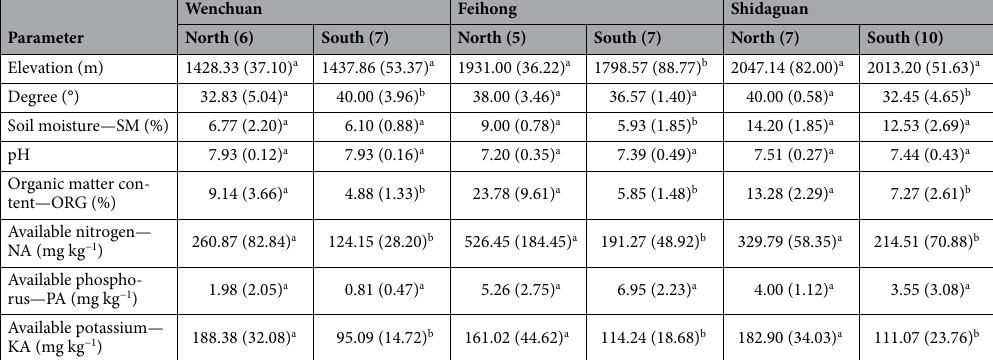
Table 1. Results of one-way ANOVA comparison of numerical environmental variables between slope aspects for all studied sites. Mean and standard deviation (SD) followed with different letters indicate significant differences at p < 0.05 between north and south aspects. Number of sampling plots within each slope is presented in brackets.